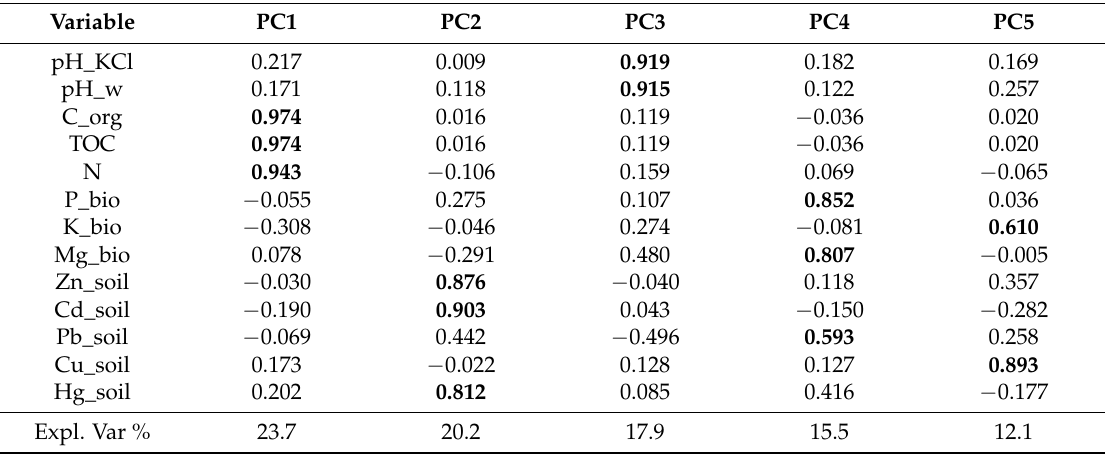
Table 2. Factor loadings for 13 variables.